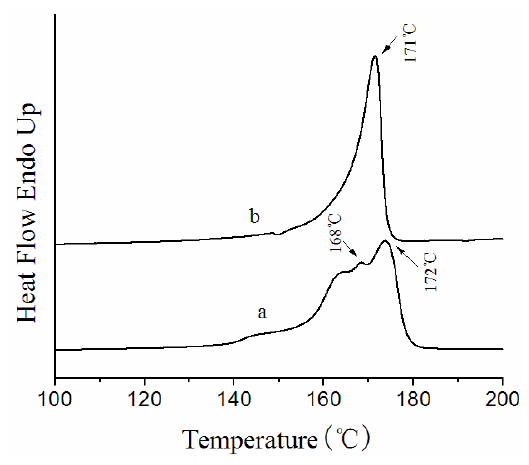
Figure 5. Differential scanning calorimetry (DSC) curves of ( a ) NIPS membrane; ( b ) melt spinning membrane.